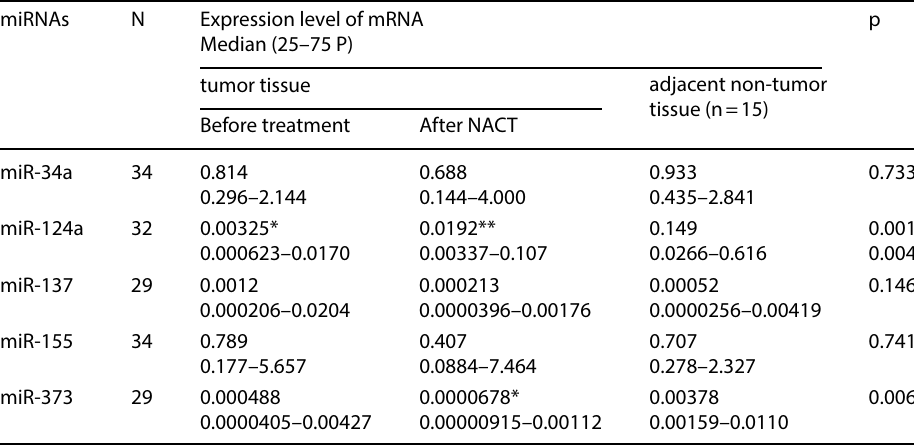
Fig. 1 The increased expres- sion of miR-124a in primary tumor tissue after treatment in patients with HR-positive BC (p < 0.05)